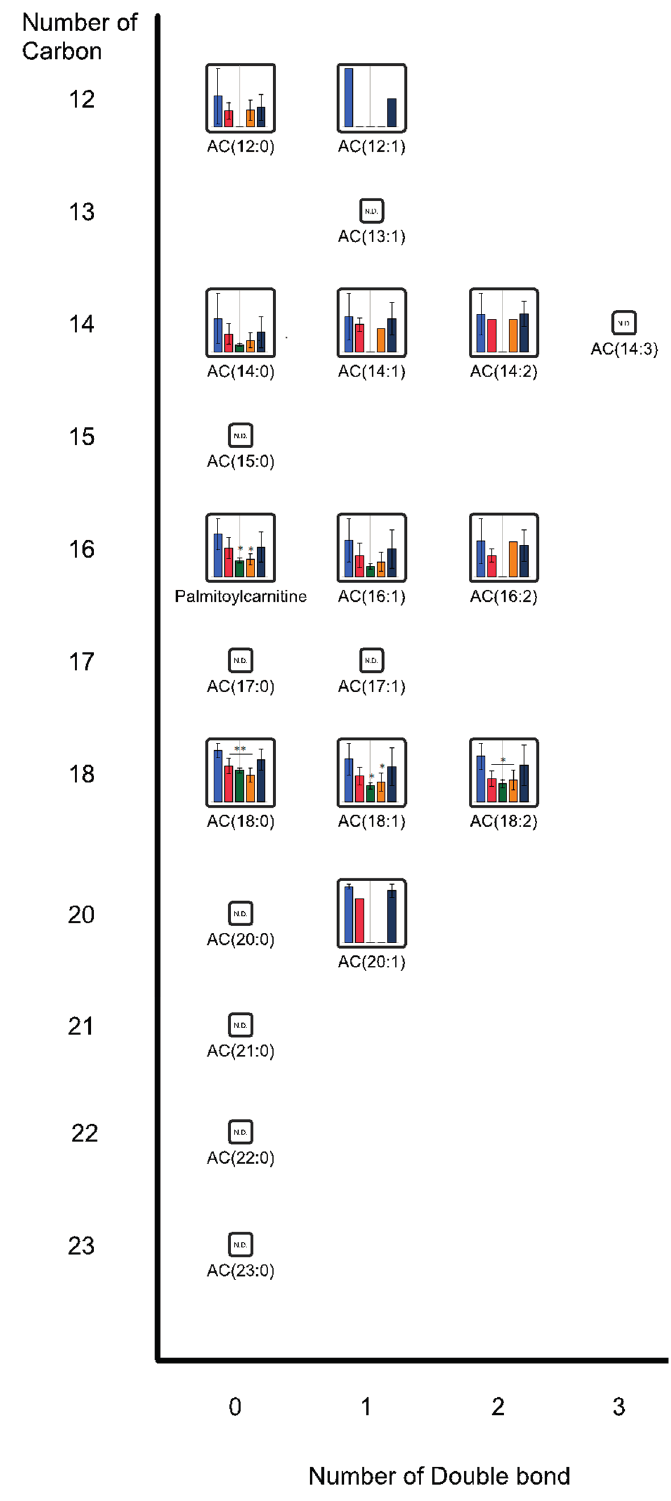
Figure 3. Plasma acyl-carnitine (AC) levels. Each bar represents median ± standard deviation (SD) of metabolite in each group. * p < 0.05, ** p < 0.01 indicate significant differences in metabolite concentrations compared to the control group. All the p -values were determined using Welch’s t -test. (blue, control; red, chitin nanofibers (CNFs); green, surface-deacetylated (SDA) CNFs; orange, chitin; navy, cellulose nanofiber (CLNF); N.D.: not